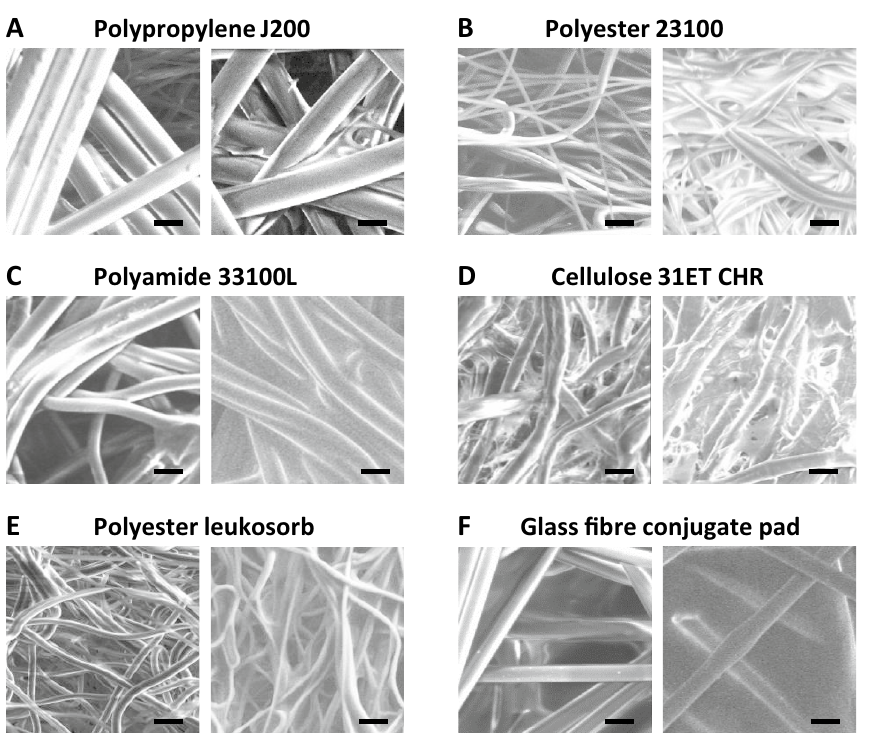
Figure 3. Physical appearance of fibres and sugar glass formed in matrices. Scanning electron microscopy images of six different matrices at × 1000 magnification. Within each panel, the left-hand image shows empty matrices and the right-hand image shows fibres after loading and drying of 0.5 M (80:20) trehalose:sucrose solution. Scale bar shows 20 µm in each